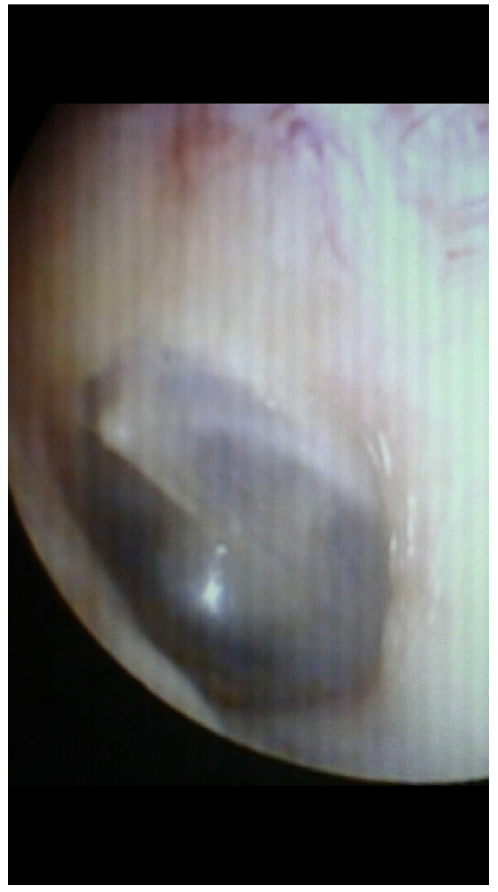
Figure 3 Tympanic membrane after application of bacterial cellulose graft, on microscopic examination.